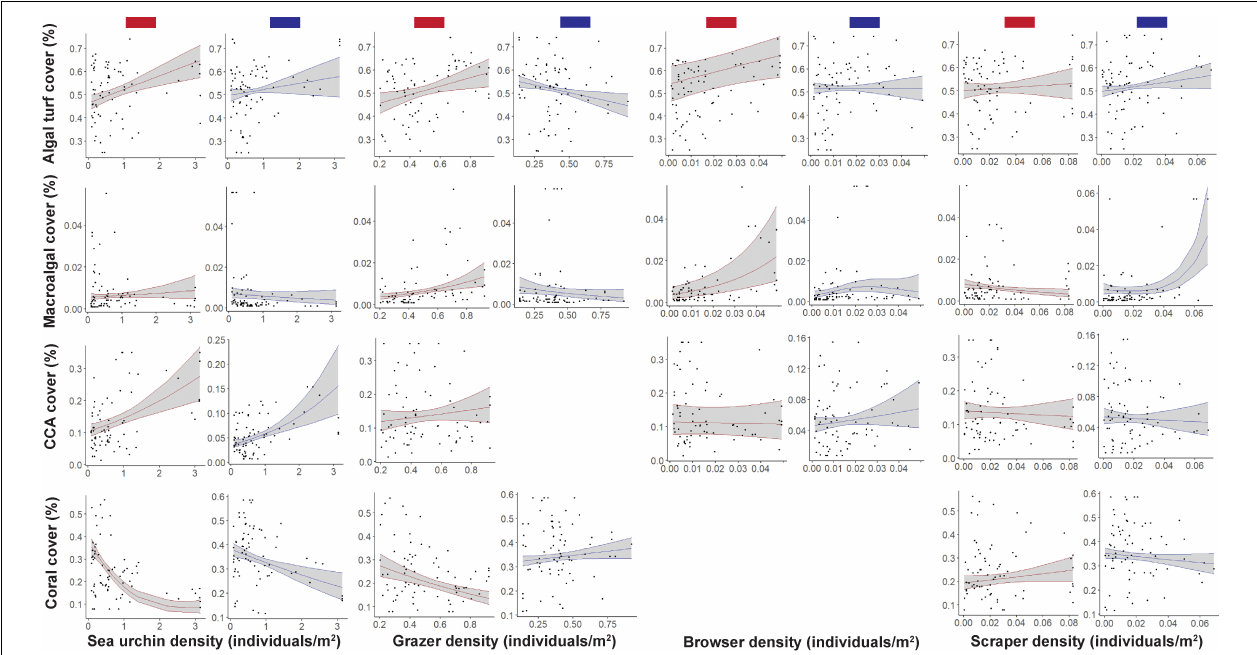
FIGURE 4 | The proportion of benthic cover relative to different herbivore densities across warm (red bars) and cool (blue bars) years. Relationships are separately plotted for each benthic cover type [algal turf, macroalgae, crustose coralline algae (CCA), and coral] and herbivore type (sea urchin, grazer, browser, and scraper) where survey data were matched with SSTA data from the previous year. Solid lines are smoothers of each driver, where only the drivers retained in the top models are shown, with shaded areas indicating 95% confidence bands. Proportion of benthic cover is shown on the y -axis of each plot, with the various herbivore densities on the x -axis, with increasing values toward the right edge of each